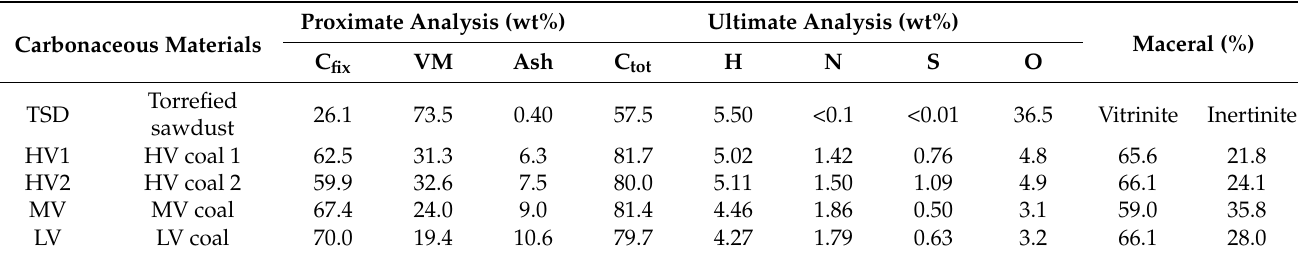
Table 1. Proximate, ultimate analysis results for carbonaceous materials and maceral composition of coal (dry